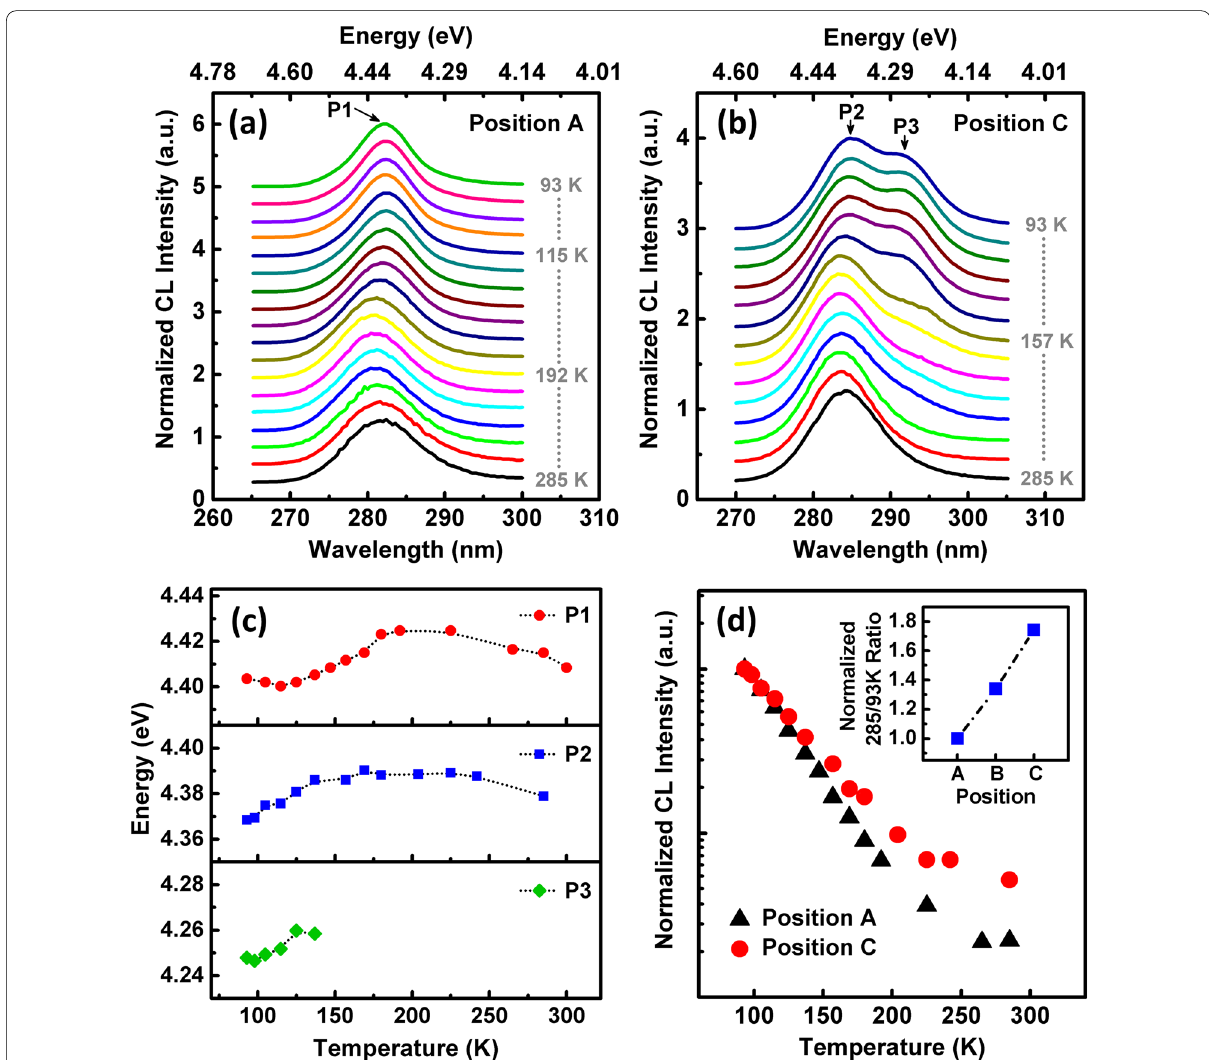
Fig. 6 Normalized temperature-dependent CL spectra taken in the a Position A and b Position C. c Variation in P1, P2 and P3 energy with temperature, which were extracted by Gaussian fitting. d Temperature dependence of the integrated CL intensity of Position A and C. The inset shows the normalized 285/93 K CL integral intensity ratio of three